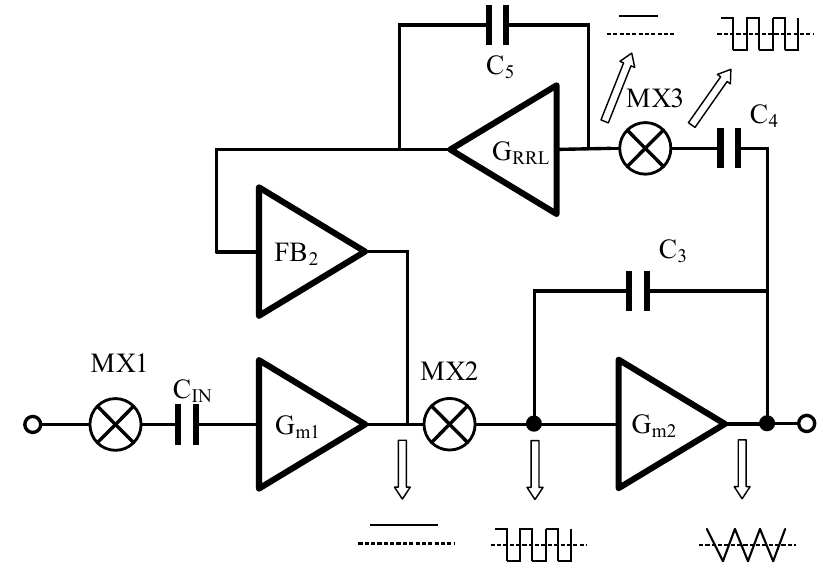
Figure 8. Simplified block diagram of the Ripple Reduction Loop (RRL).